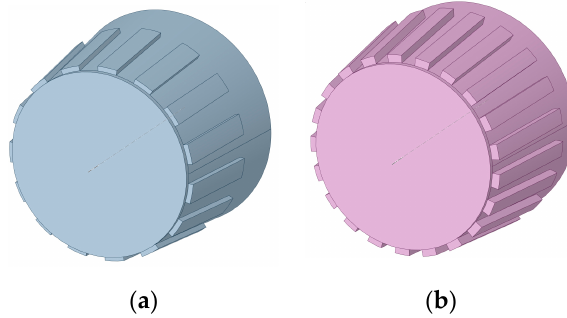
Figure 20. Comparison between ( a ) initial ( b ) optimal J-Groove models installed on the draft tube walls.